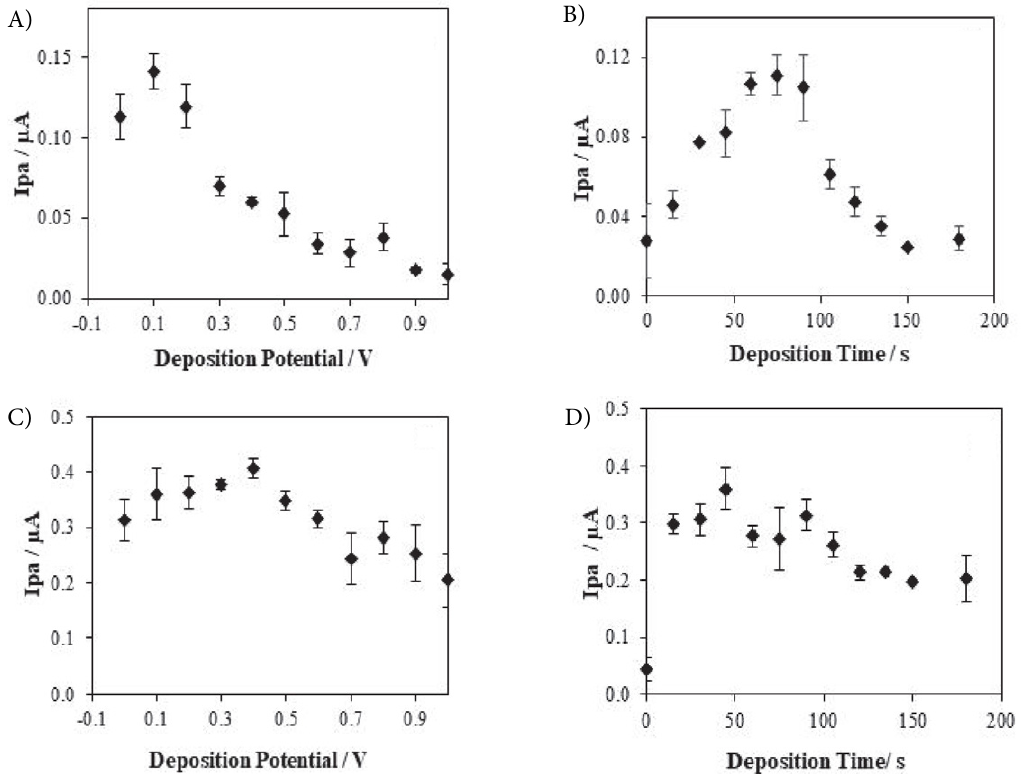
Figure 7. Effect of deposition potential and deposition time on peak current shown in AdsDPV method (A, B) and AdsSVW method (C, D) record- ed in the presence of 1.0 ∙ 10 –7 M KC at CCPE electrode in 0.04 M BR buffer pH